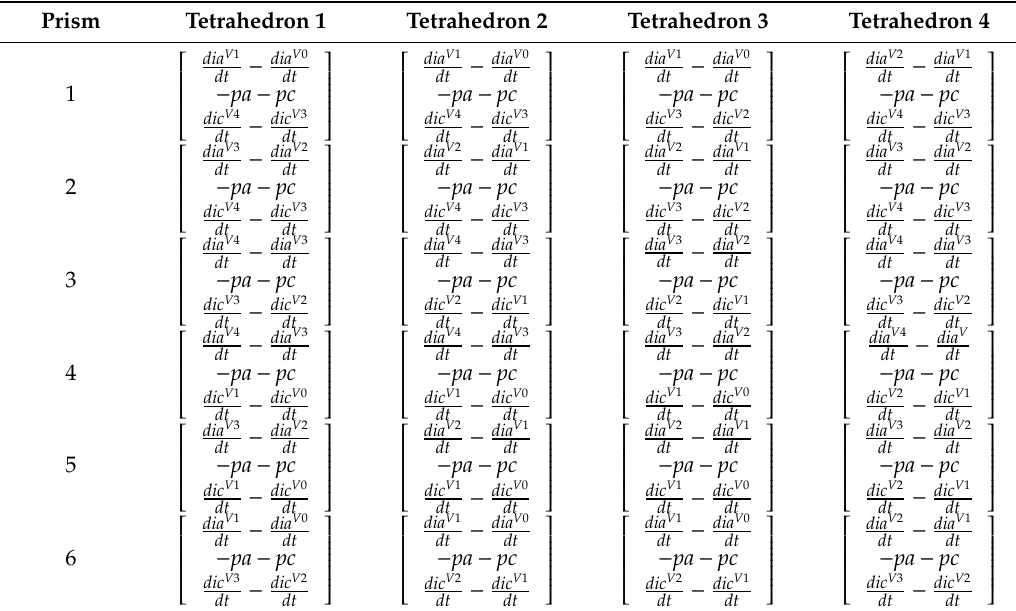
Table 7. Selection of the saturation saliency position scalars P a , P b , and P c for a fault-tolerant PMSM drive under a loss of phase “b”.